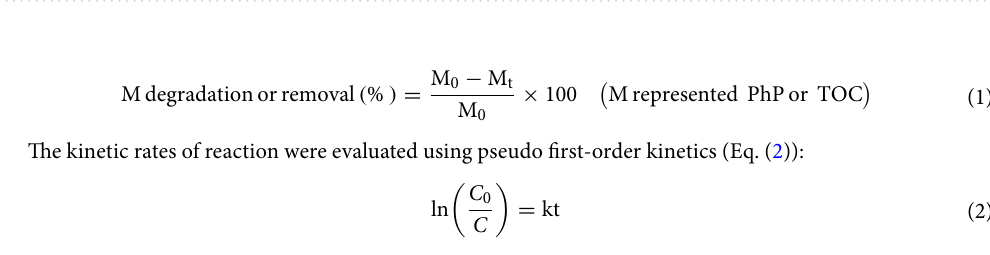
Figure 2. Schematic diagram of catalytic ozonation